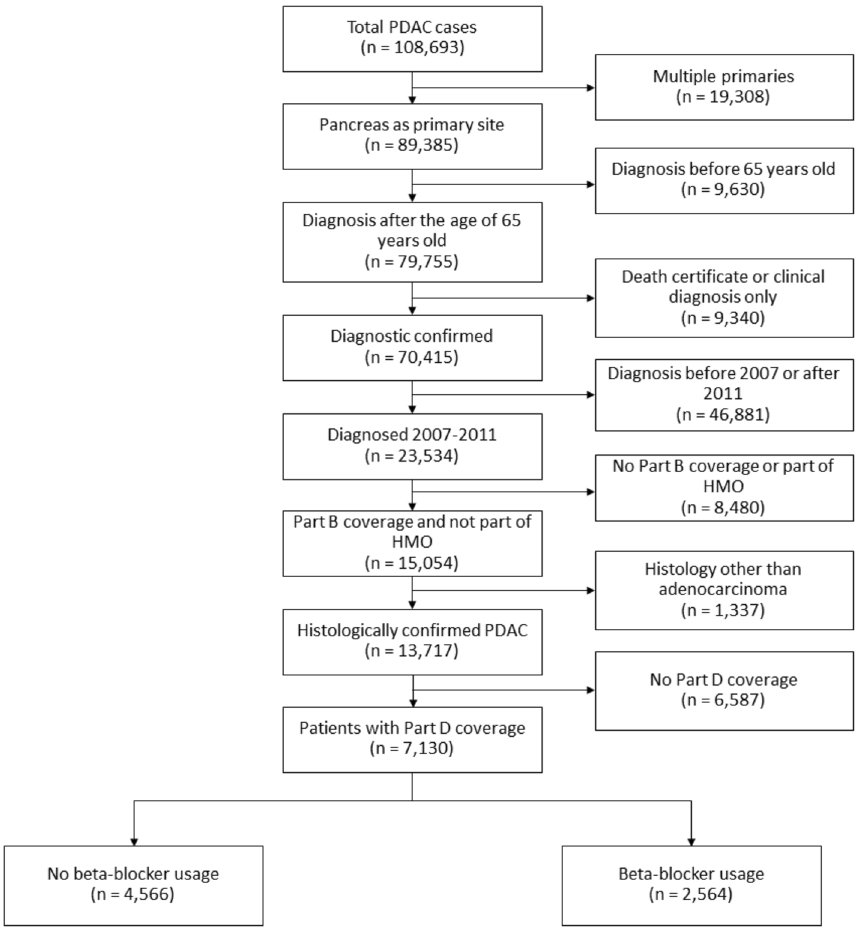
Figure 1. Cohort selection. PDAC pancreatic ductal adenocarcinoma, HMO health-care maintenance